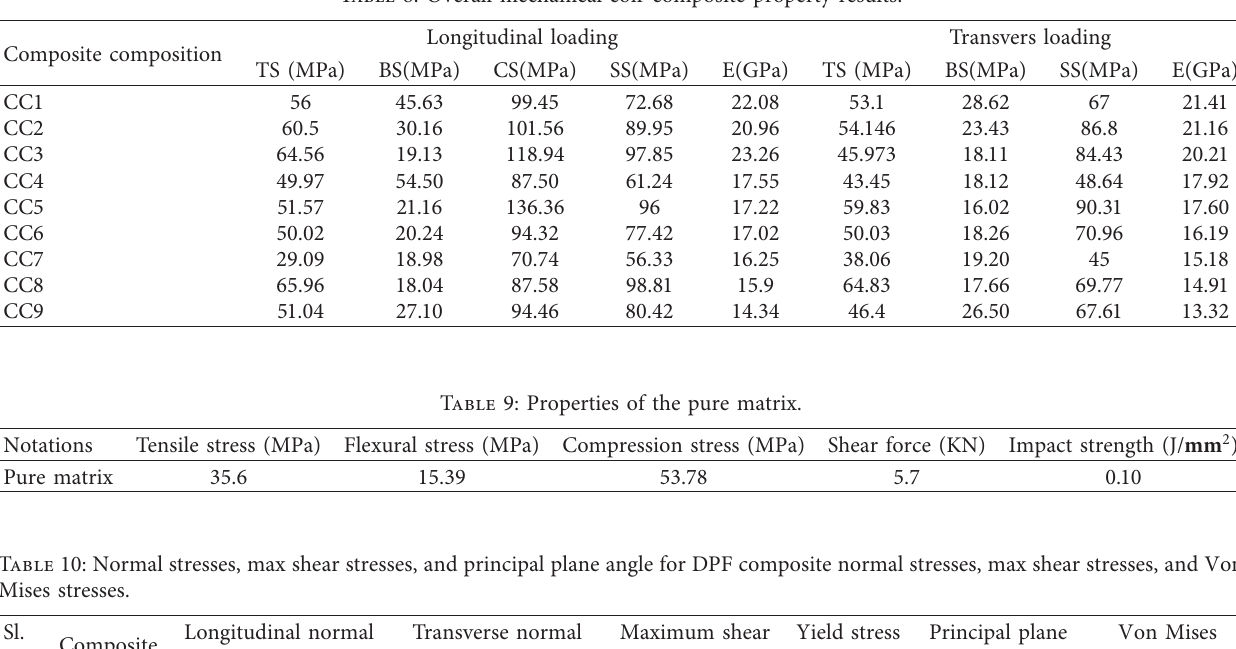
Table 8: Overall mechanical coir composite property